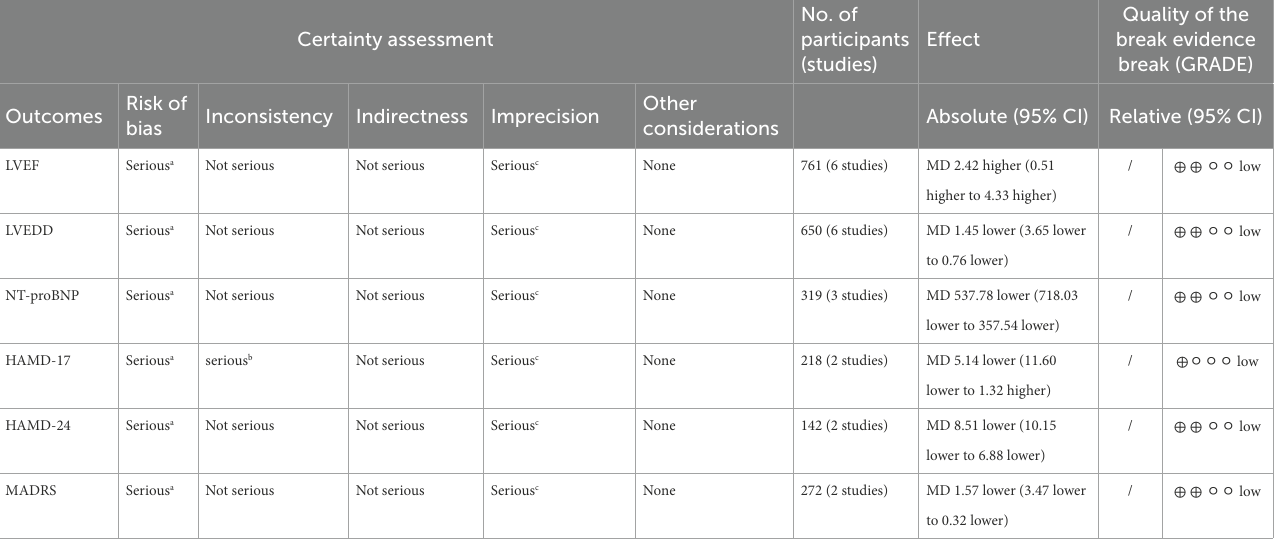
Certainty assessment